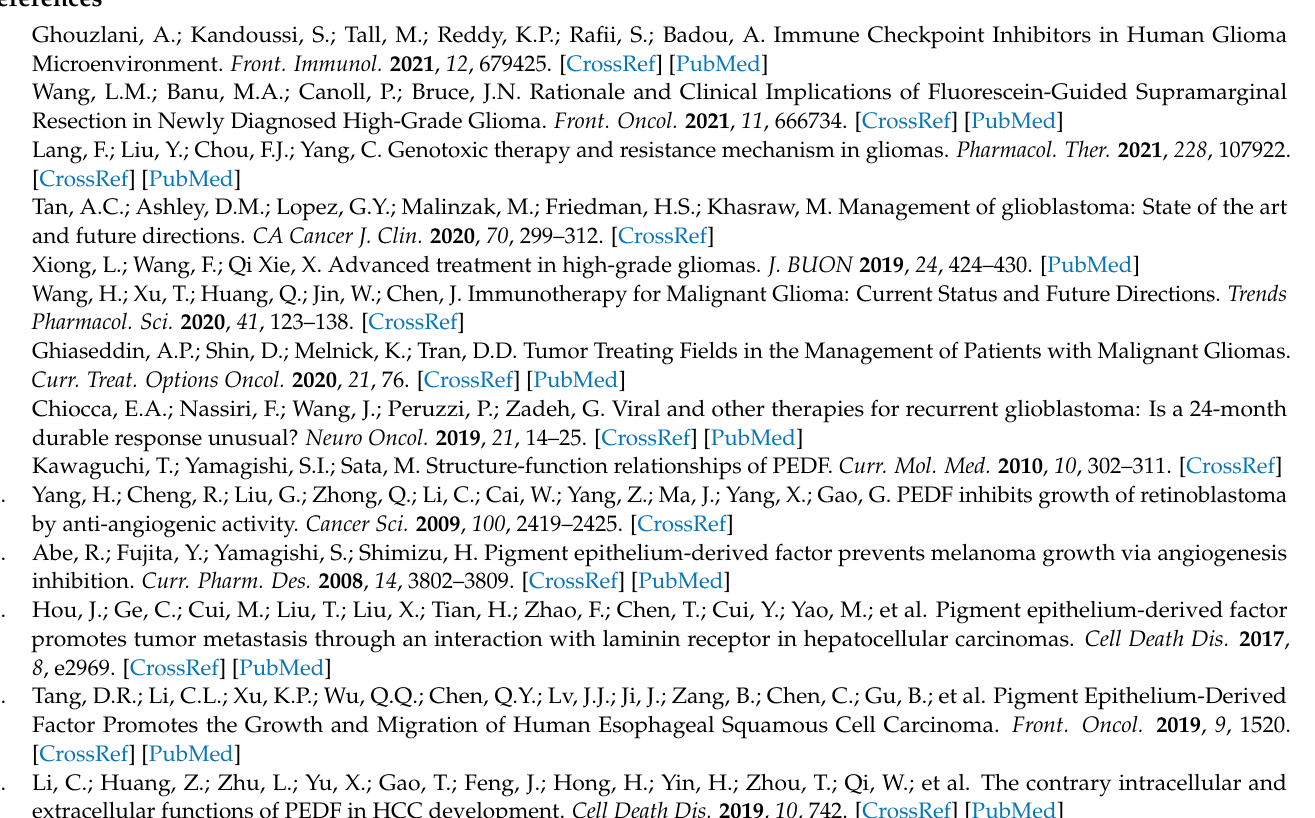
Table S1: The sequences of siRNAs and